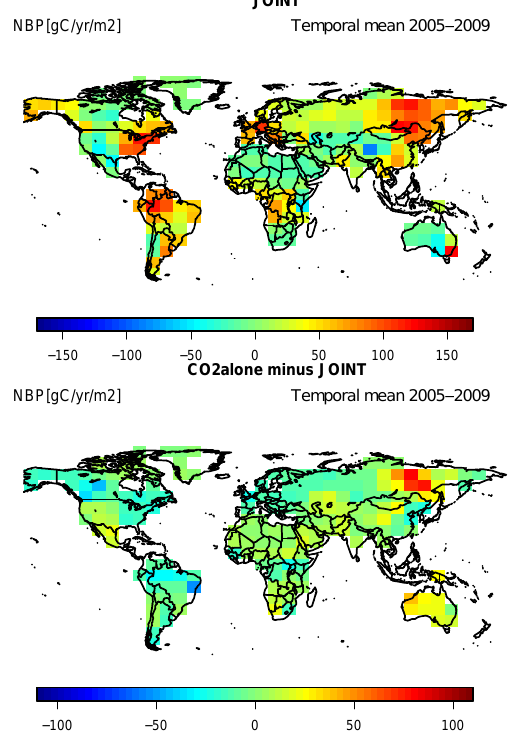
Figure 6. Temporally averaged NBP of the JOINT assimilation, and the difference between the CO2alone and JOINT experiments.